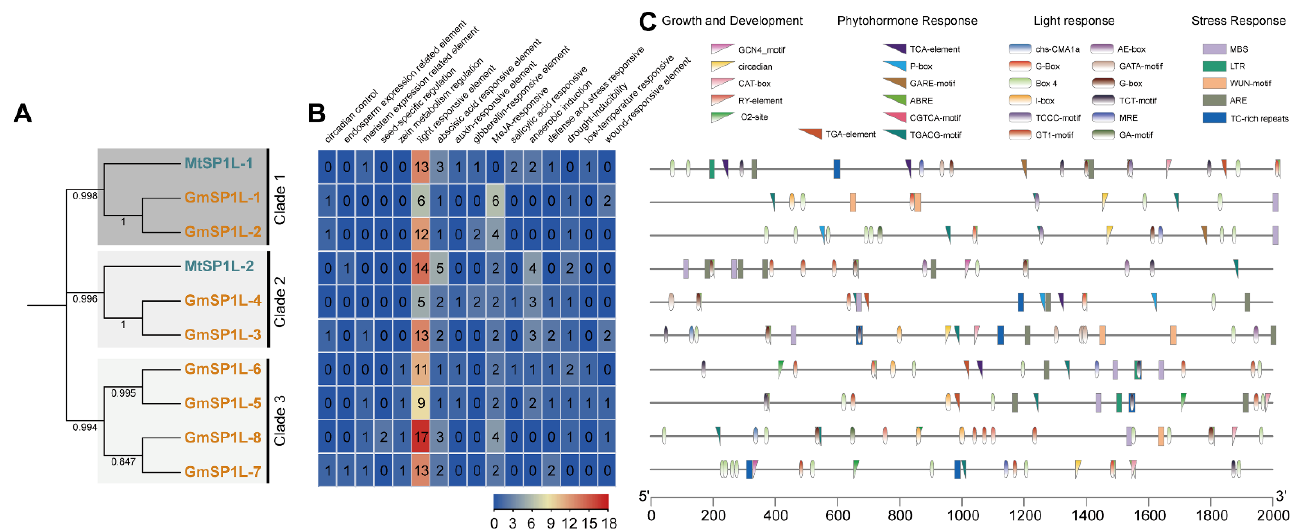
Figure 5. Putative cis-elements and transcription factor binding sites in the promoter regions of the SP1L genes from M. truncatula and G. max . ( A ) The groups and color are as indicated in Figure 1. ( B ) The color and number of the grid indicate the numbers of different cis-acting elements in these SP1L genes. ( C ) The colored blocks represent different types of cis-acting elements and their locations in each SP1L gene.